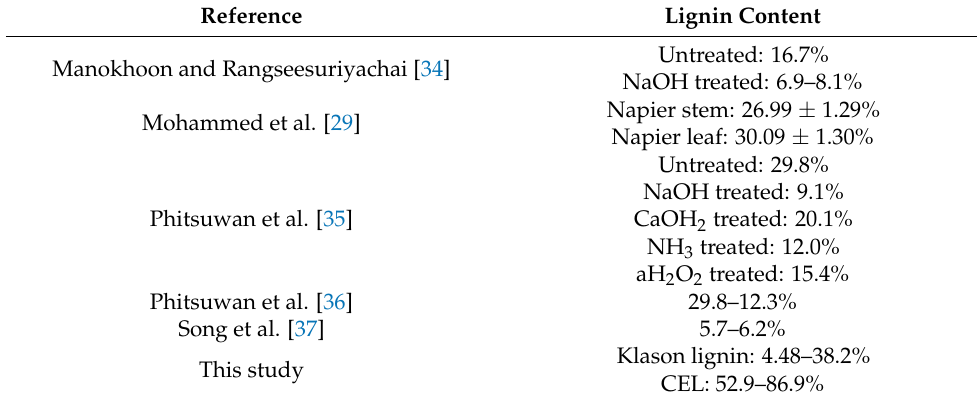
Table 13. Comparison of lignin content from previous and current